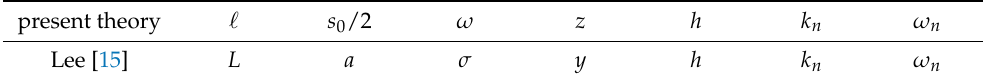
Table 1. Cross Reference of symbols between Lee [15] and present